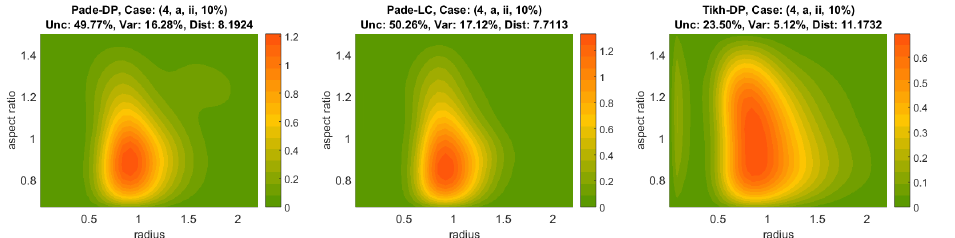
Figure 4. Shape-size distribution reconstructions produced by Padé-DP, Padé-LC and Tikh-DP (left to right) for the case (4, a, ii) respectively for 1% and 10% error level. The uppermost plot corresponds to the initial shape-size distribution. The triple (Unc, Dist, Var) in the title of each plot refers to residual-error quantities of shape-size distribution.